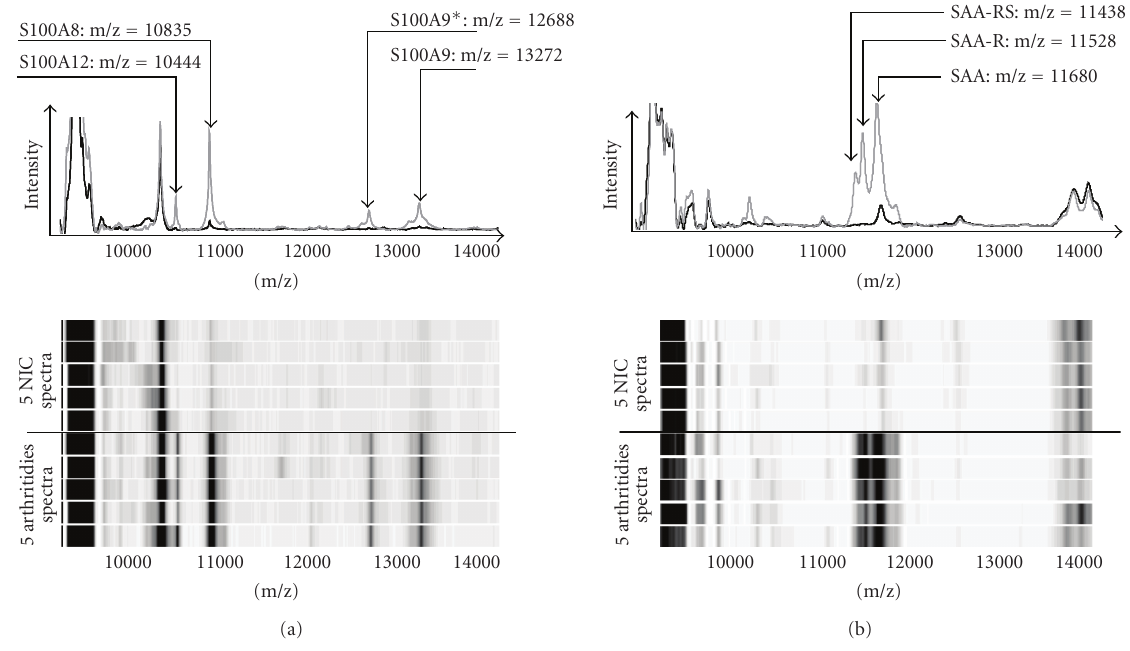
Figure 3: Protein mass spectra collected on CM10 and IMAC-Cu 2+ ProteinChip arrays with serum samples provided by five patients with arthritidies (including rheumatoid arthritis, psoriatic arthritis and ankylosing spondylitis) and five noninflammatory controls (NIC) (including osteoarthritis). (a) The inflammatory-related proteins S100A8, S100A12, S100A9, and one of its variant S100A9 ∗ are arthritis biomarkers detected on CM10 arrays. (b) On IMAC-Cu 2+ ProteinChip arrays, SAA and its 2 variants (SAA-R and SAA-RS) are illustrated, reproduced from [19].